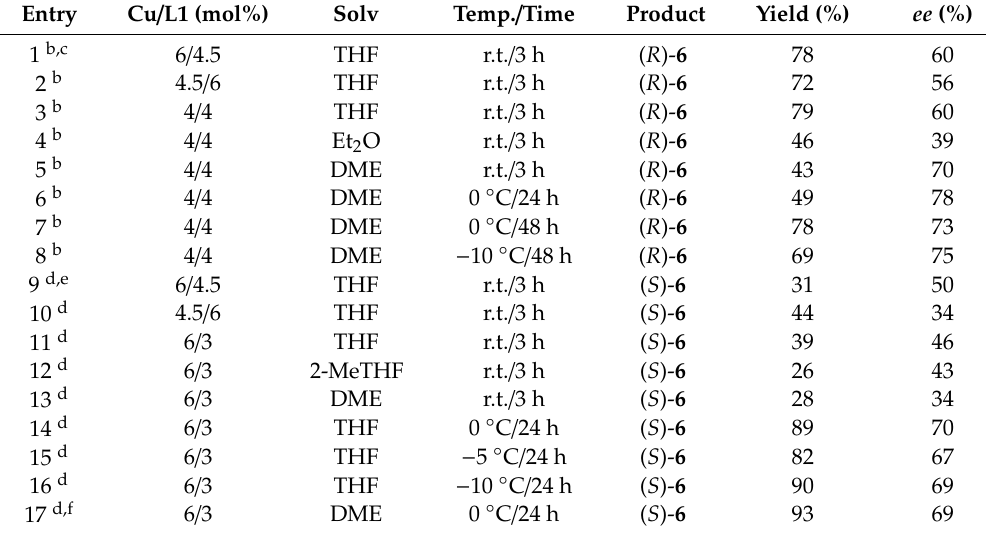
Table 5. Switching of stereoselectivity in the conjugate addition reaction of 5 under selected conditions a .